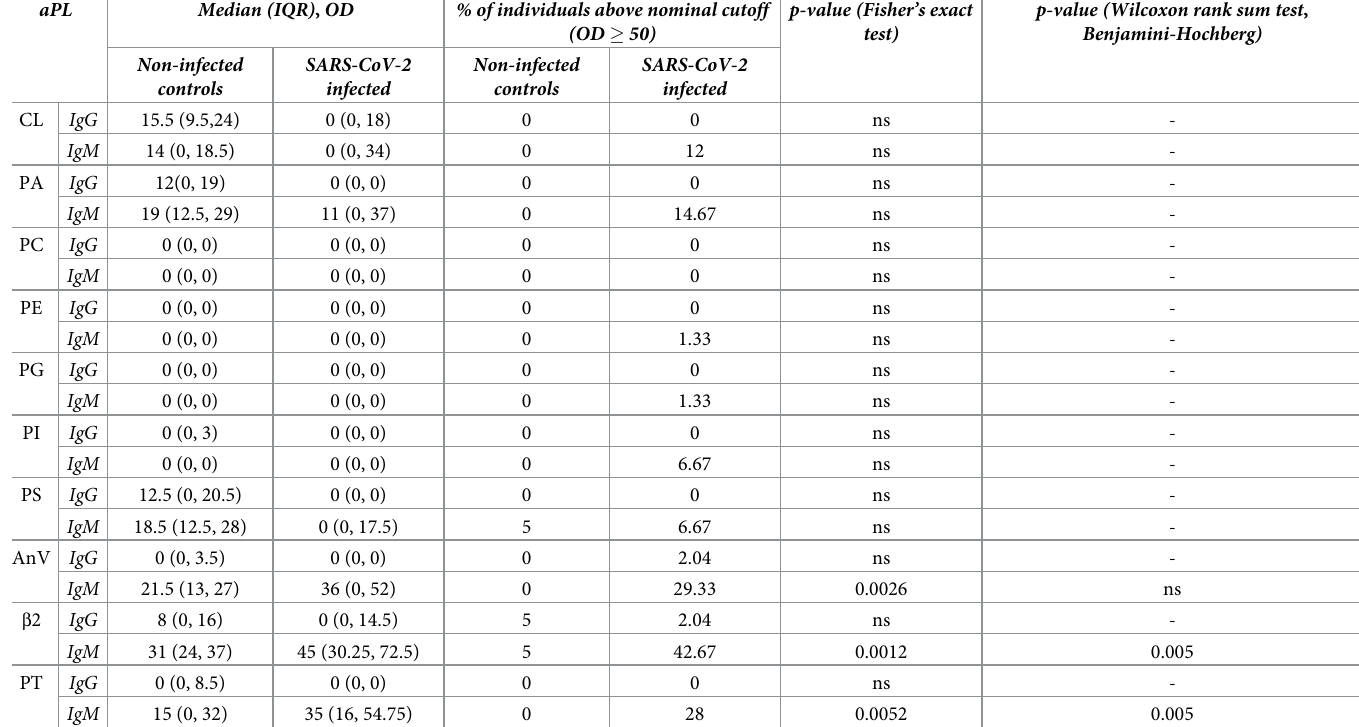
Table 3. Overview of antiphospholipid antibodies (aPL) and pair-wise statistical testing (AnV, annexin 5; β 2, β 2-glycoprotein I, IQR, interquartile range; CL, OD, optical density; PA, phosphatidic acid; PC, phosphatidylcholine; PE, phosphatidylethanolamine; PG, phosphatidylglycerol; PI, phosphatidylinositol; PS, phosphati- dylserine; PT,